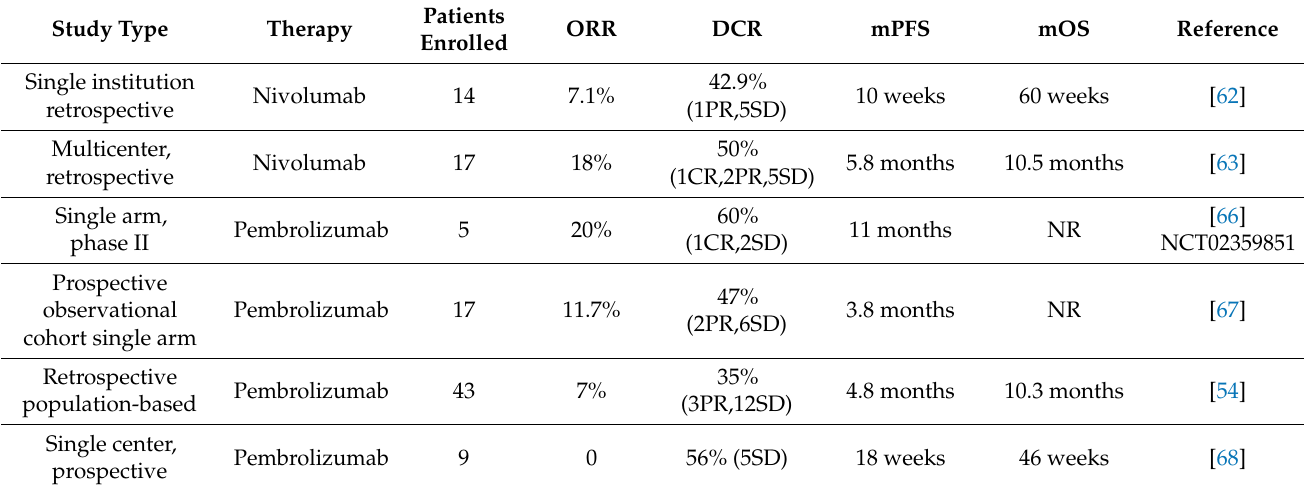
Table 3. Clinical studies with PD-1/PD-L1 inhibitors in metastatic UM